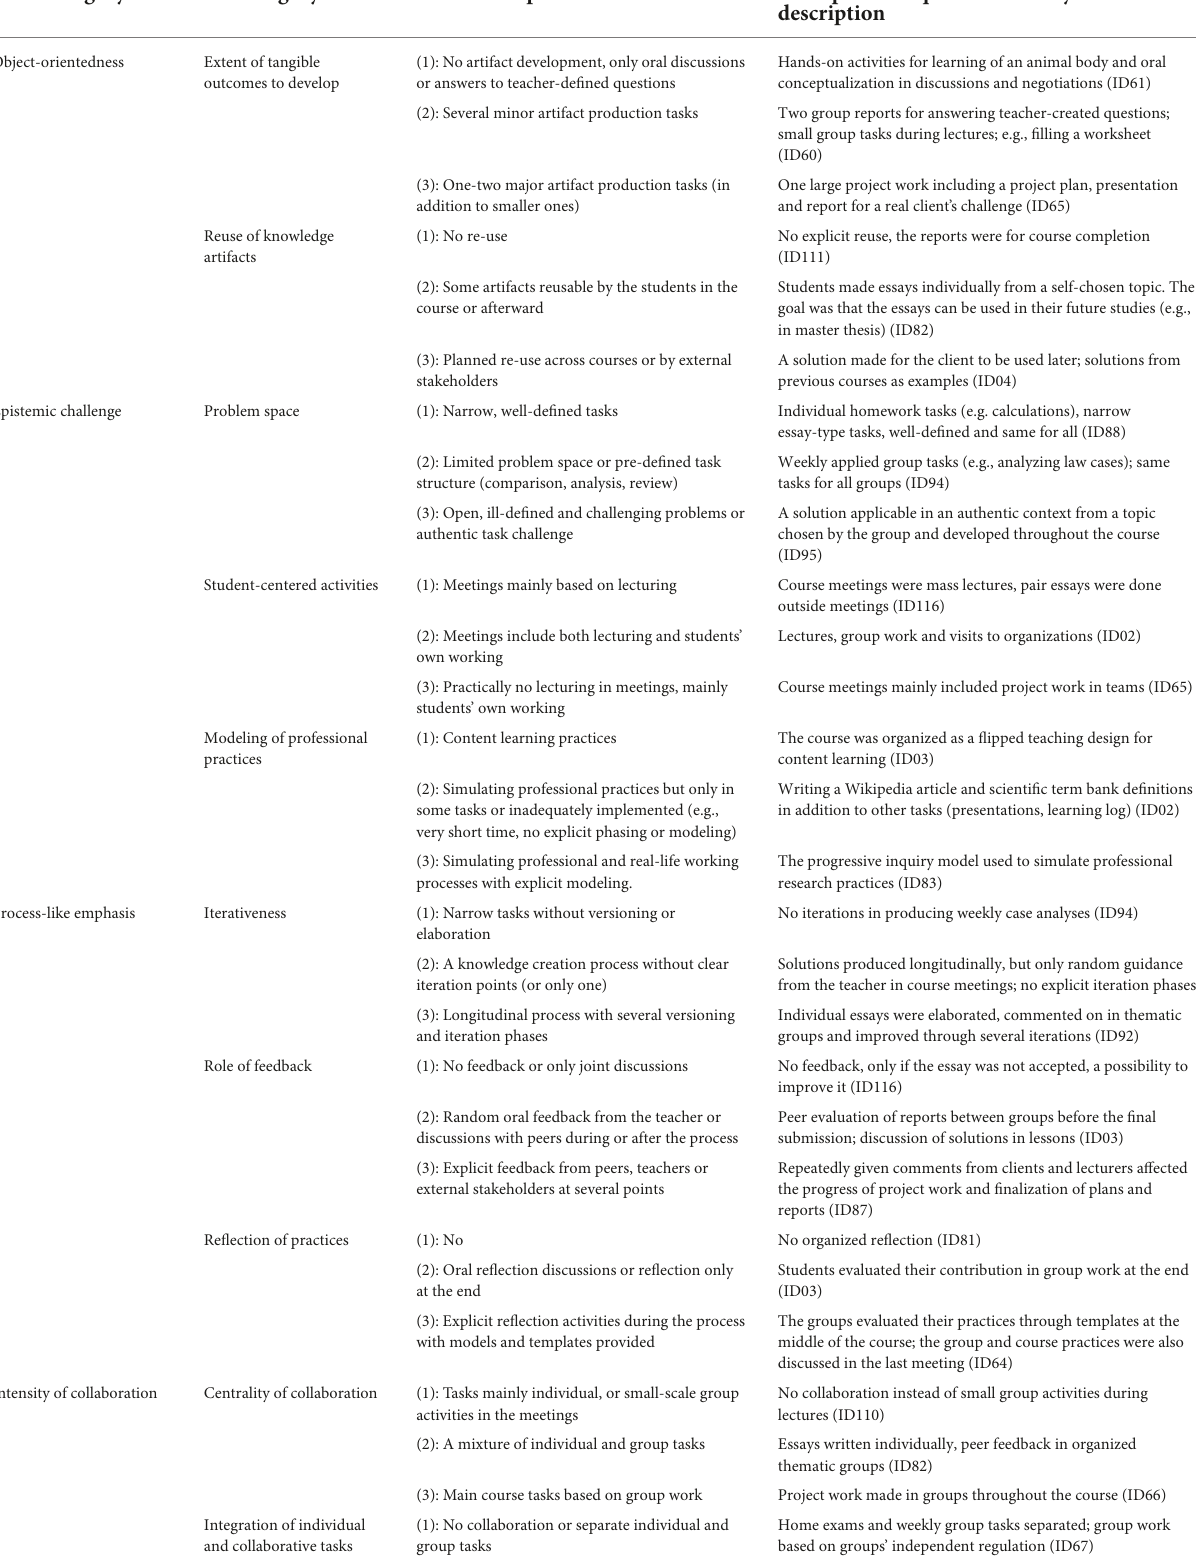
TABLE 2 Categorization, level descriptions and examples from the analysis of pedagogical